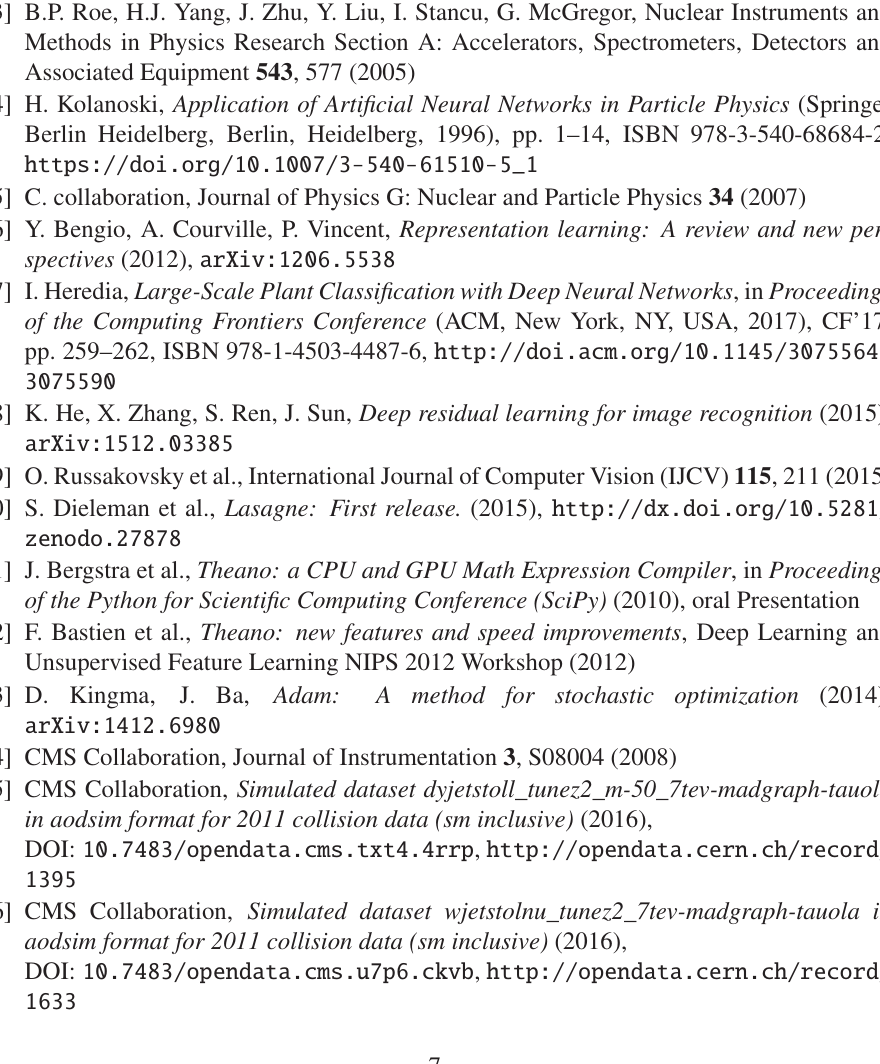
Figure 3. Confusion matrices for the test set using convolutional neural networks.